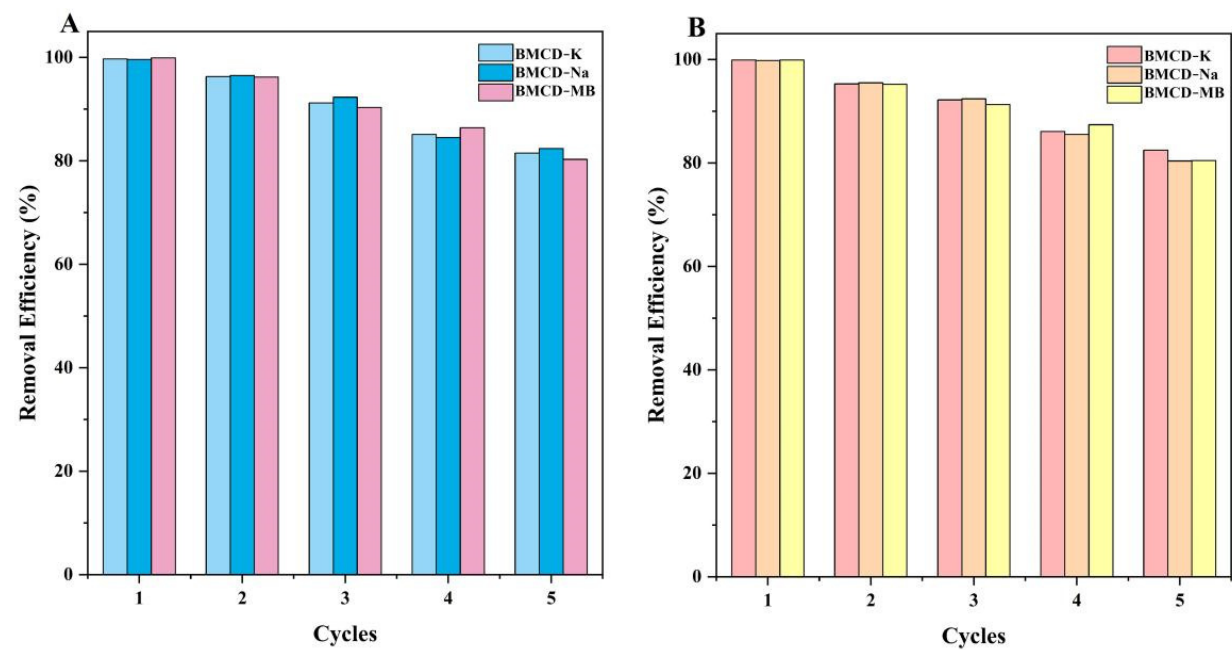
Figure 10. Reusability of the BMCD-K, BMCD-Na, and BMCD-MB for ( A ) RhB and ( B ) TH.